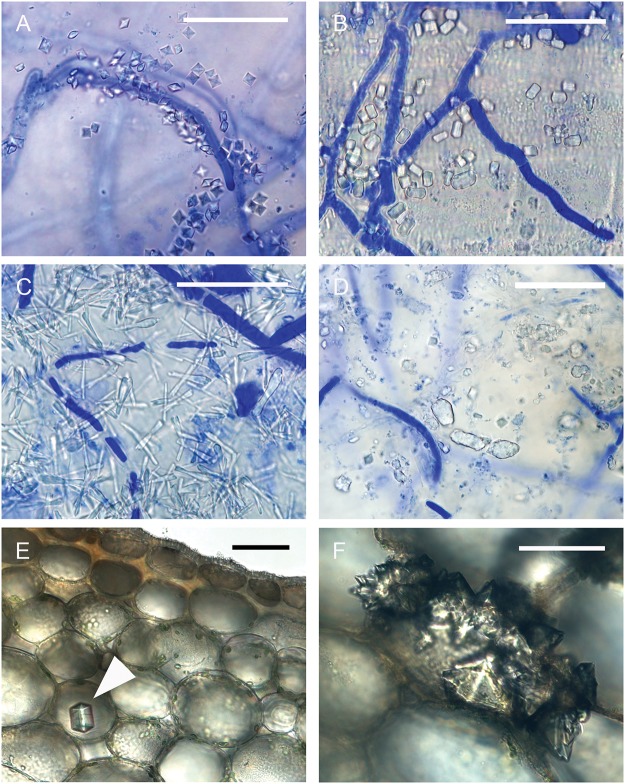
Crystal shapes (72 hpi).Light micrographs illustrating hyphae and crystal shapes observed on Brassica carinata infected with Sclerotinia sclerotiorum at 72 hours post inoculation: A-D: Four crystal shapes on the surface of stems. For these, the epidermis and the first few layers of cortical cells were cut from stems decolorized in acetic acid: ethanol: water (2:2:1), stained in 0.05% aniline blue and observed on glass slides. Photographed using an Olympus BX51 microscope and DP71 digital photographic system. A: bipyramidal crystal B: short rod crystals C: long rod crystals D: irregular—crystal sand. E, F: The presence of crystals in the stem cortex was revealed when transverse sections 200 μm thick were cut with a Vibratome 3000 sectioning system from stems fixed in glutaraldehyde, then observed under bright field illumination on glass slides. Photographed using Zeiss Axioplan microscope and Zeiss Axiocam digital photographic system. E: Tetragonal short rod crystal (arrow) within the stem cortex. F: Jagged crystals formed on the surface of a cortical cell. A, B, C, D, E, F, Scale bars = 50 μm.